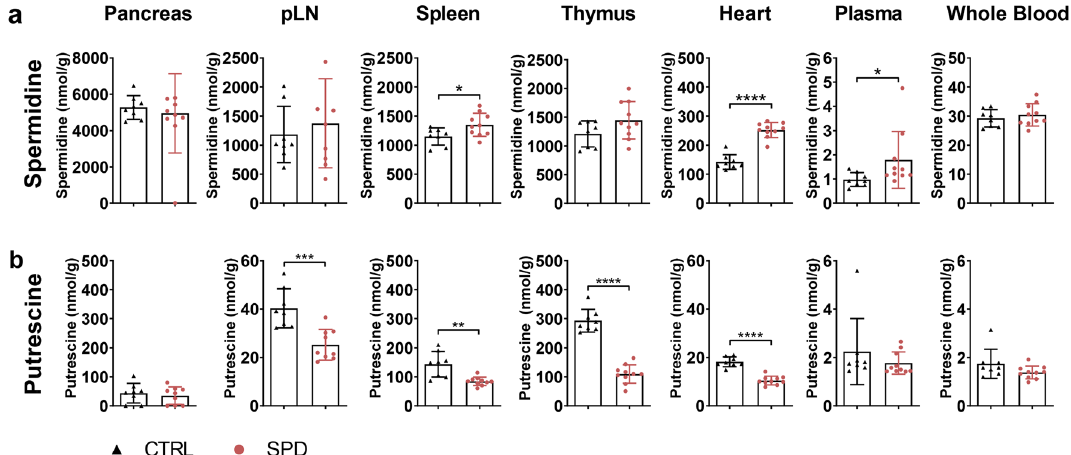
Figure 5. Daily oral spermidine treatment enhanced endogenous spermidine levels in male NOD mice. ( a ) Spermidine and ( b ) putrescine levels were analyzed in pancreas, pLN, spleen, thymus, heart, plasma and whole blood after 4 weeks of 10 mM spermidine treatment. Black triangles show ctrl mice (n = 8) and red circles show spd mice (n = 10). Data is shown as nmol/g and mean ± SD. Mann–Whitney U test or unpaired Student’s t -test was used as statistical analysis . p * < 0.05, p ** < 0.01, p *** < 0.001, p **** <